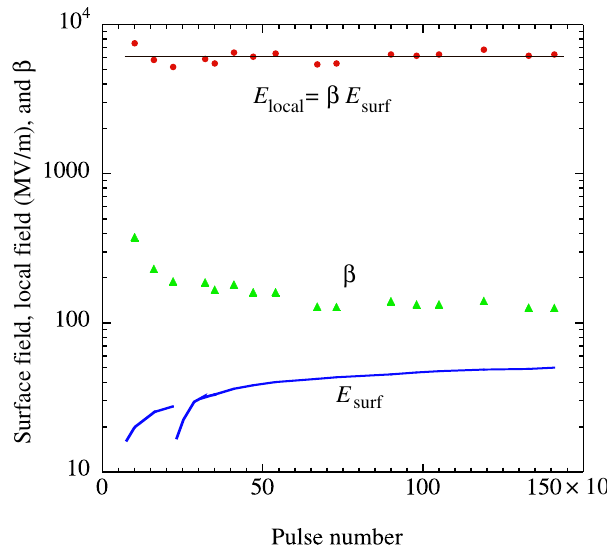
FIG. 8. (Color) Local electric fields in KEK data, (cid:1)E conditioning [31,47]. During this period the average accelerating , increases by a factor of 2 and the enhancement factor, field, E surf (cid:1) , measured from FN plots, decreases by the same factor, plotted logarithmically for comparison. The model predicts constant E during conditioning. local